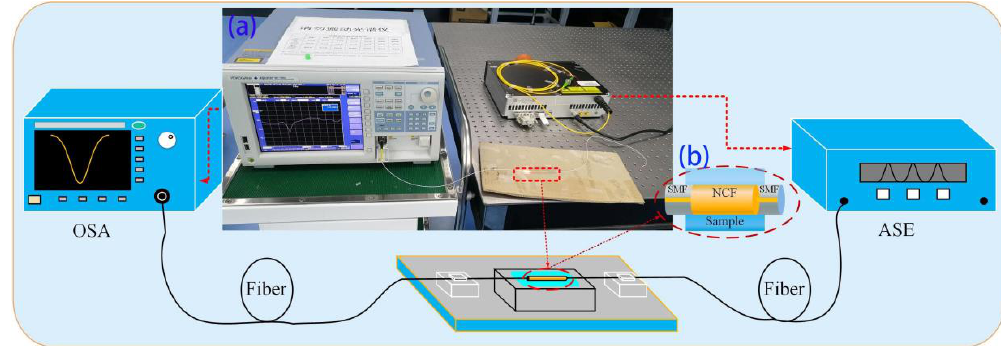
Figure 5. Diagram of experimental device. ( a ) Sensor test experiment device diagram. ( b ) Enlarged view of experimental apparatus.